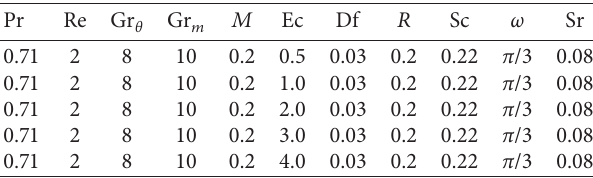
Table 3: Values of the change in Eckert number.